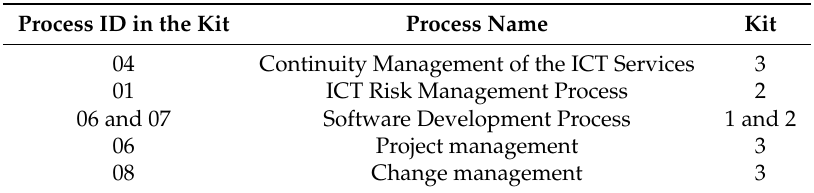
Table 3. Processes to be implemented in the